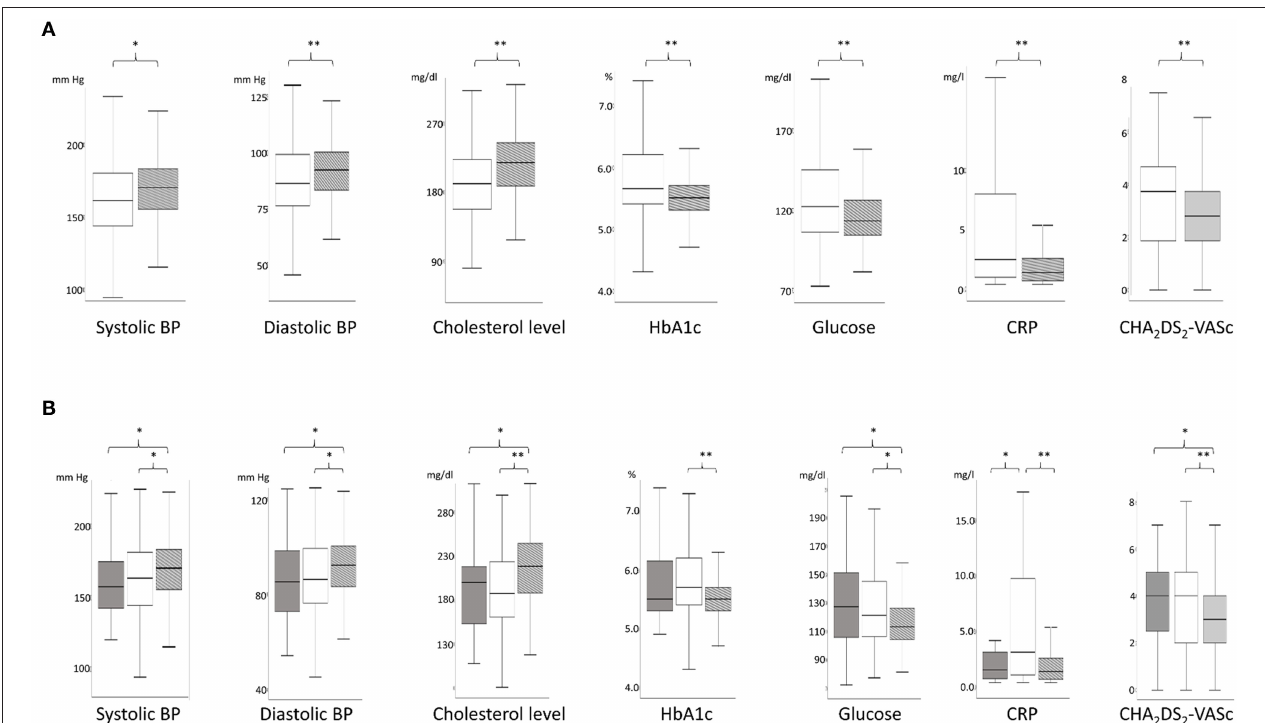
FIGURE 2 | (A) Comparison of the parameters of the vascular risk profile between patients with stroke (AIS-patients, white) and TGA (TGA-patients, gray) using boxplots. * p < 0.05; ** p < 0.001. In this figure, stroke patients include patients with transient ischemic attack (TIA) and completed stroke (CS). (B) Comparison of the parameters of the vascular risk profile between patients with TIA (TIA-patients, dark gray; left boxplots), completed stroke (CS-patients, white, middle boxplots), and TGA (TGA-patients, light gray, right boxplots). * p < 0.05; ** p <